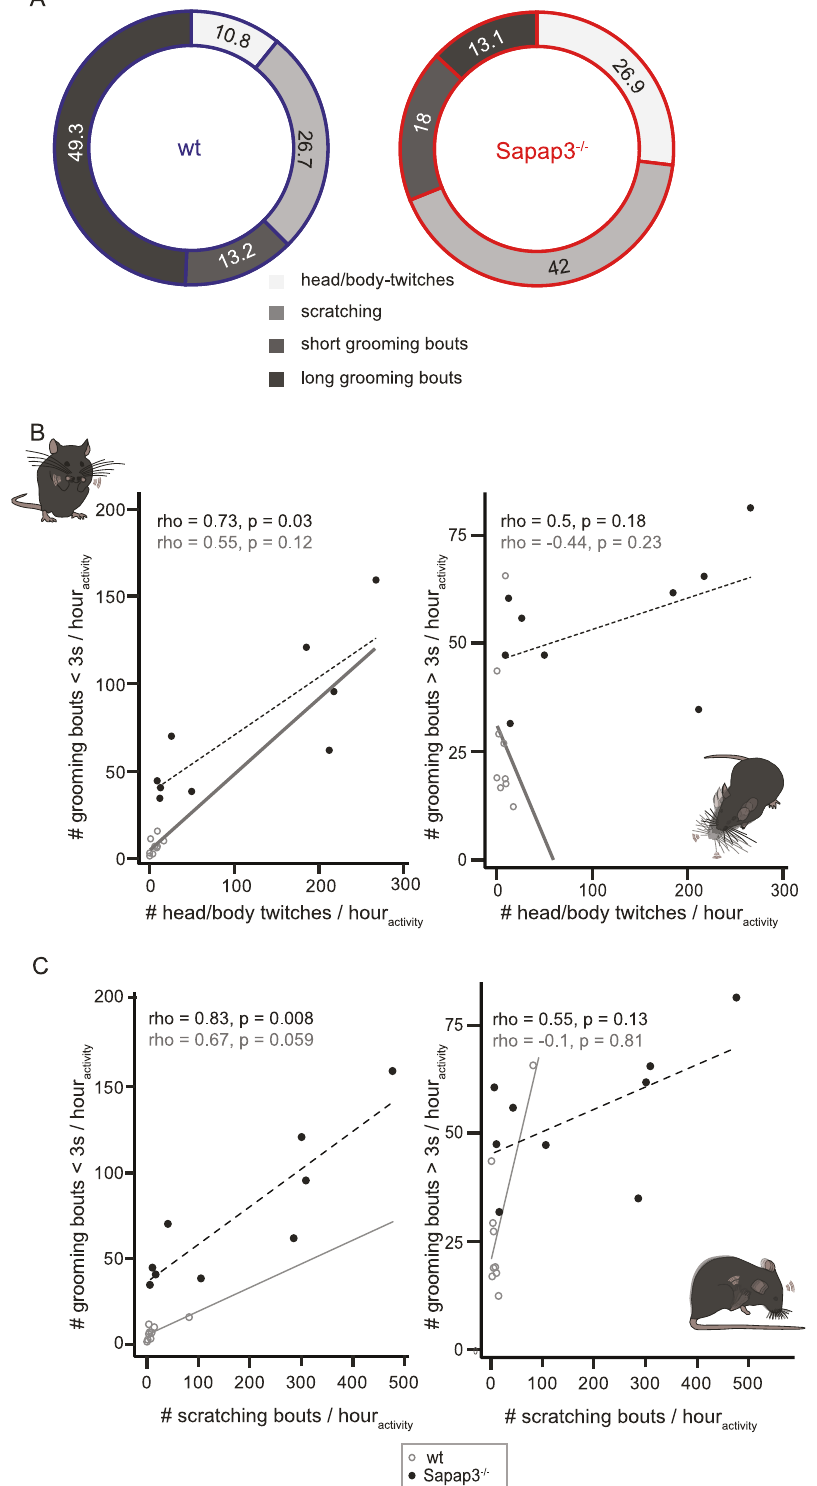
Fig. 4 Excessive head/body twitches, scratching and short grooming events are associated in Sapap3 − / − mice. A The proportion of novel detected repetitive behaviours in Sapap3 − / − mice outweighs previously reported syntactic self-grooming behaviour (Pearson ’ s χ 2 test, p < 0.0001). B Head/body twitches positively correlate with short, single-phase grooming but not long, syntactic grooming bouts in Sapap3 − / − mice (Spearman correlation, p < 0.05, p = ns, respectively). C Scratching bouts also correlate positively with short, single-phase grooming but not long, syntactic grooming bouts in Sapap3 − / − mice (Spearman correlation, p < 0.01, p = ns, respectively). Correlation estimates are plotted in a grey solid line or a dotted black line for wildtype or Sapap3 − / − mice ( n = 9 animals per genotype), respectively.